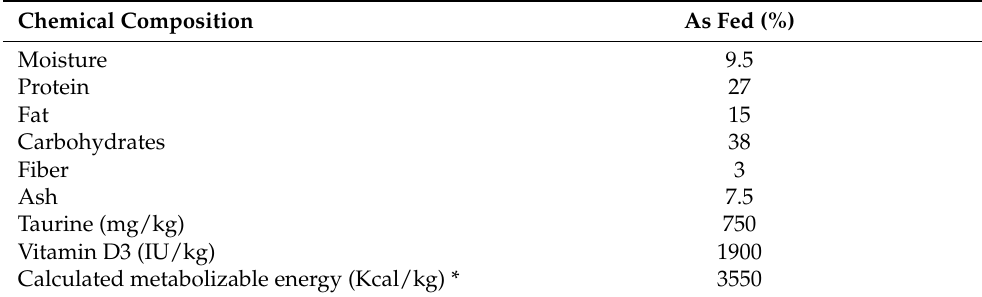
Table 1. Chemical composition and ingredients of the